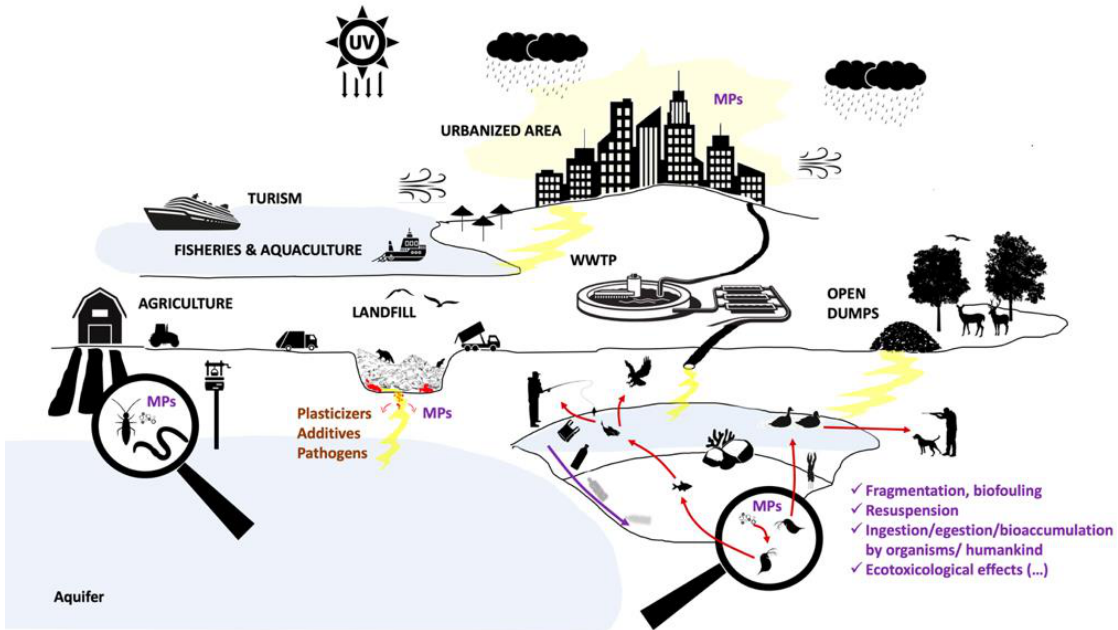
Figure 1. Schematic representation of sources, fate, and effects of plastic pollution on environmental and human health. MPs — Microplastics; UV- Ultra Violet (radiation); WWTP — Wastewater Treatment Plants